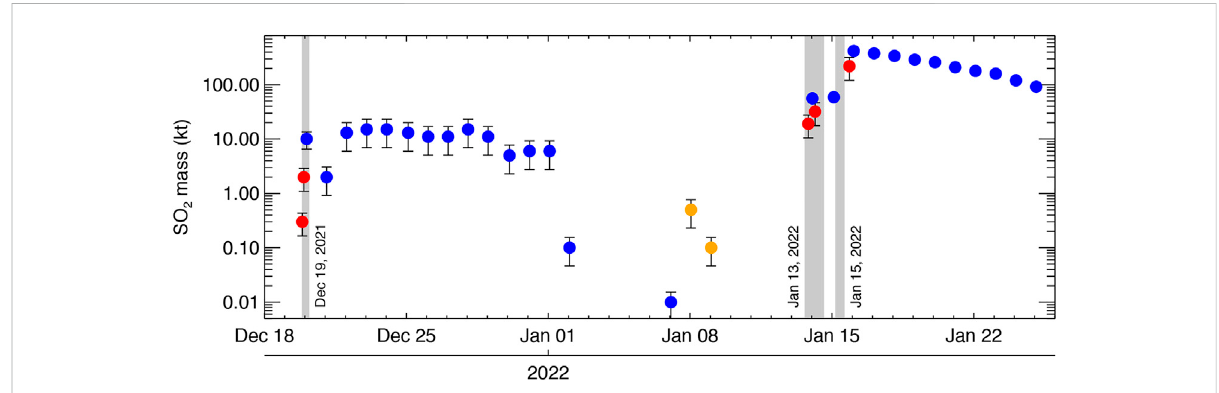
FIGURE 1 Time-seriesofSO 2 mass[inkilotons(kt)where1 kt=1,000metrictons]measuredbyDSCOVR/EPIC ( redsymbols ),SNPP/OMPS( bluesymbols ) and S5P/TROPOMI ( orange symbols ) during the December 2021 — January 2022 HTHH eruption sequence. For clarity, only selected data from Table 2 are plotted here. SNPP/OMPS SO 2 data for January 16 – 26, 2022 are also included, showing the initial dispersion of the stratospheric SO 2 cloudemittedbyHTHHonJanuary15.Errorbars(seeSection3)areonlyshownwheretheyarelargerthanthesymbolsize. Grayshading shows the approximate durations of the HTHH eruptions on 19 December 2021, 13 January 2022, and 15 January 2022, as reported by Gupta et al.